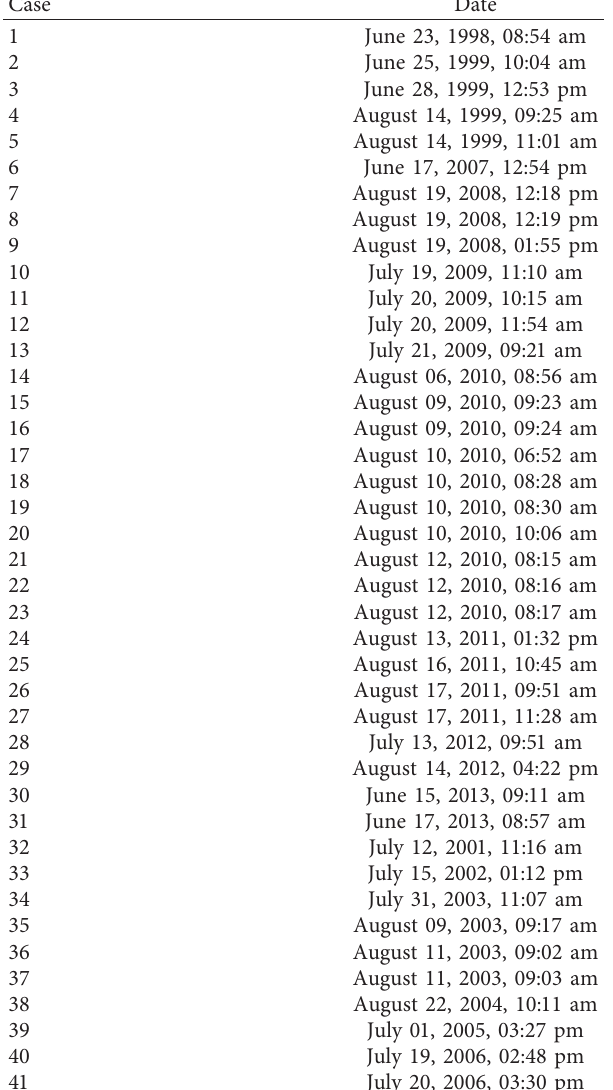
Table 1: The dates of the 41 OCS events during 1998–2013 over the